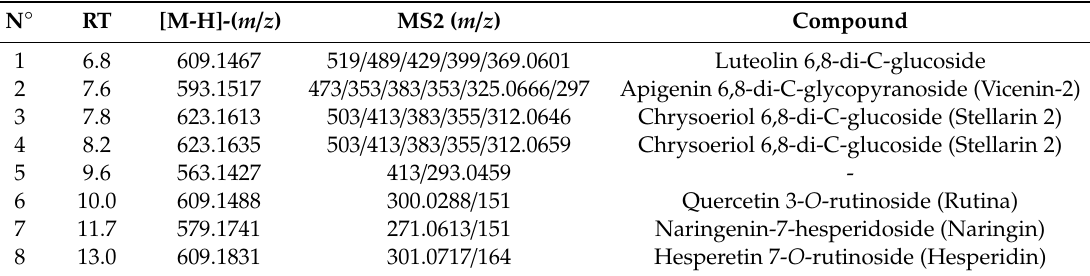
Table 3. The HPLC-DAD-ESI-QTOF-MS / MS analysis of phenolic compounds (flavonols) in orange by-product flour, retention times (RT), mass spectrum